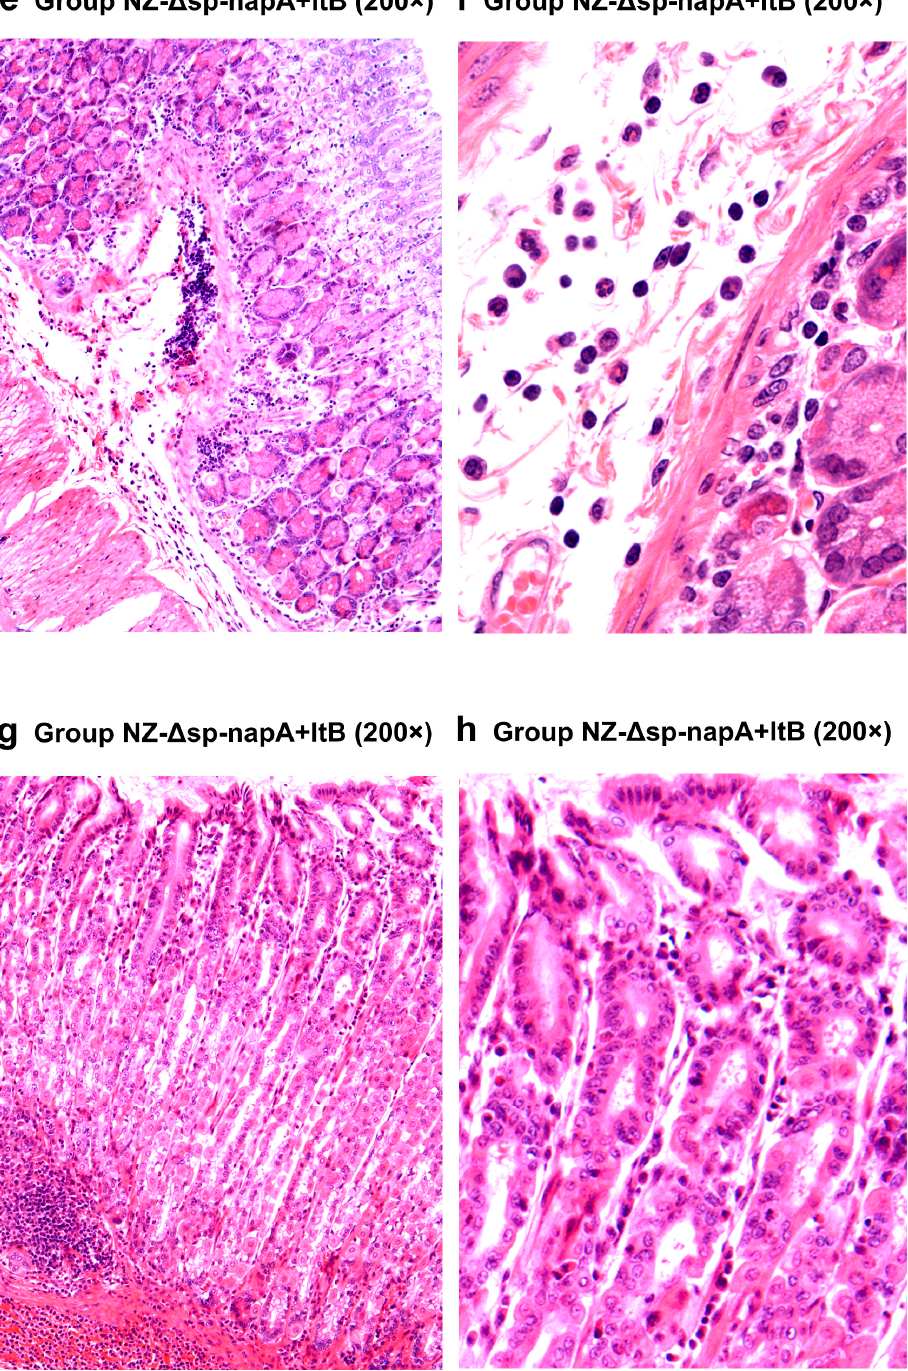
Figure 7. Histological examination of gastric tissues of the NapA+LtB immunized mice ( e – h ). NZ- ∆ sp-napA + ltB group ( n = 11) were gavaged with mixture of NZ3900 / pNZ- ∆ sp- napA and -sp- ltB and challenged with H. pylori . The gastric tissues were sampled from the mice 1 week after the challenges and examined via paraffin section and hematoxylin-eosin staining. The gastric inflammatory changes had higher severity in the NapA+LtB immunized mice than the others, characterized by more serious infiltration of leukocytes, abscess and erosion in gastric mucosa and submucosa.